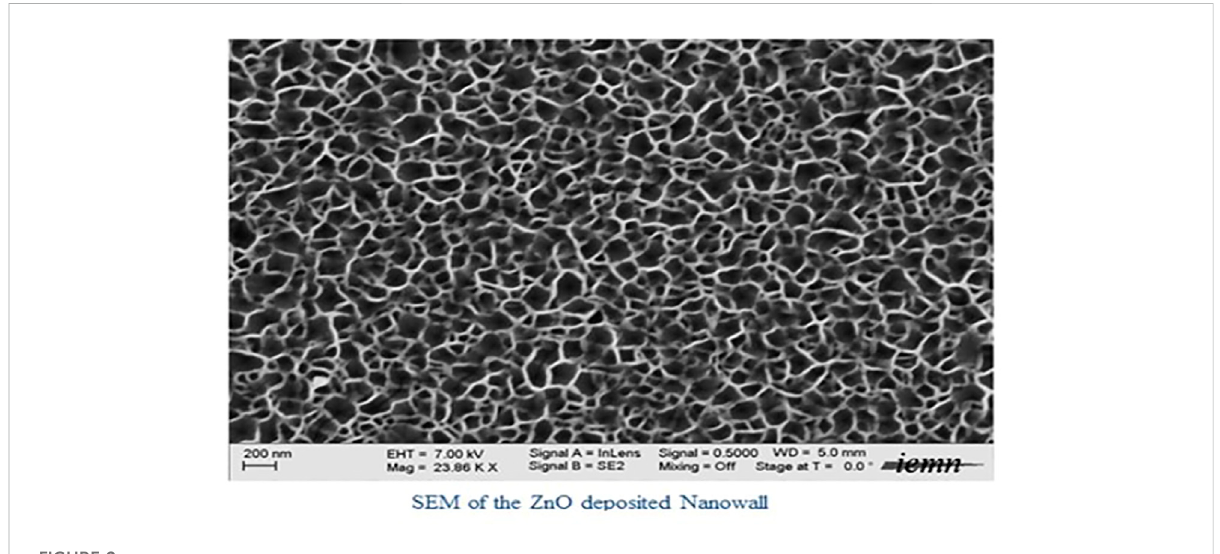
FIGURE 2 SEM image of the ZnO nanowall honeycomb structure.